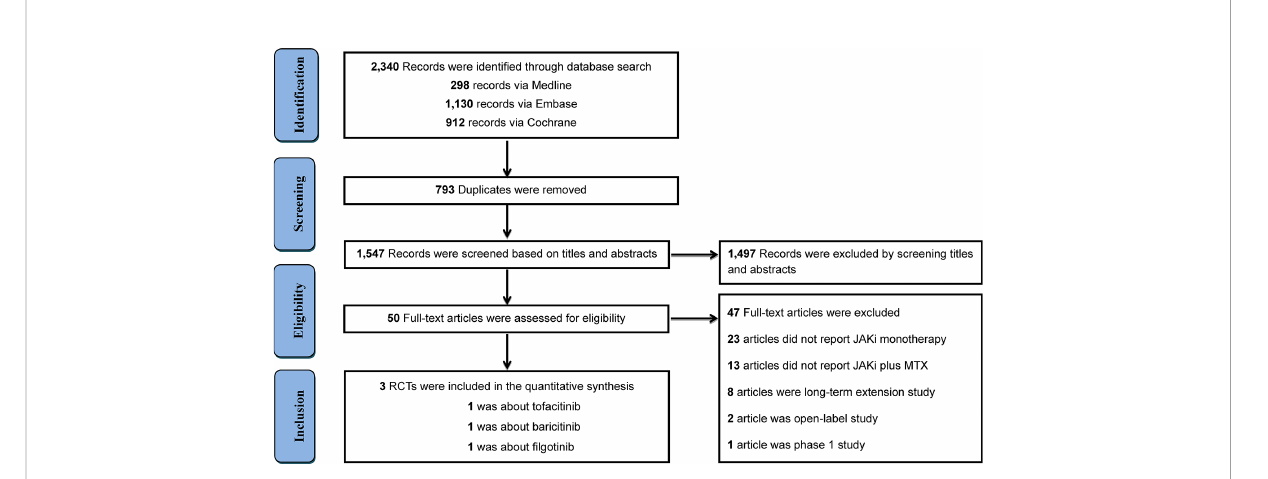
FIGURE 1 PRISMA diagram of the selection of eligible randomized controlled